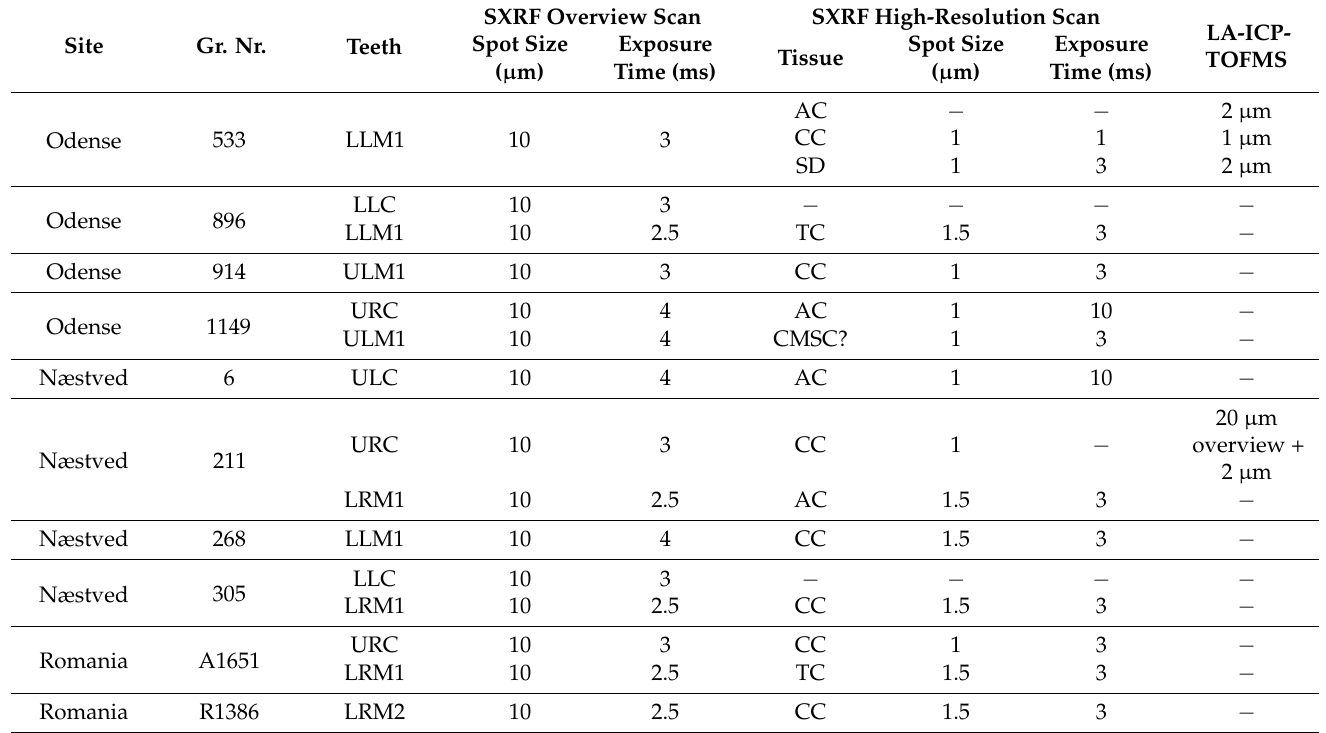
Table 1. Medieval and modern tooth samples for SXRF and LA-ICP-TOFMS multiscale imaging.